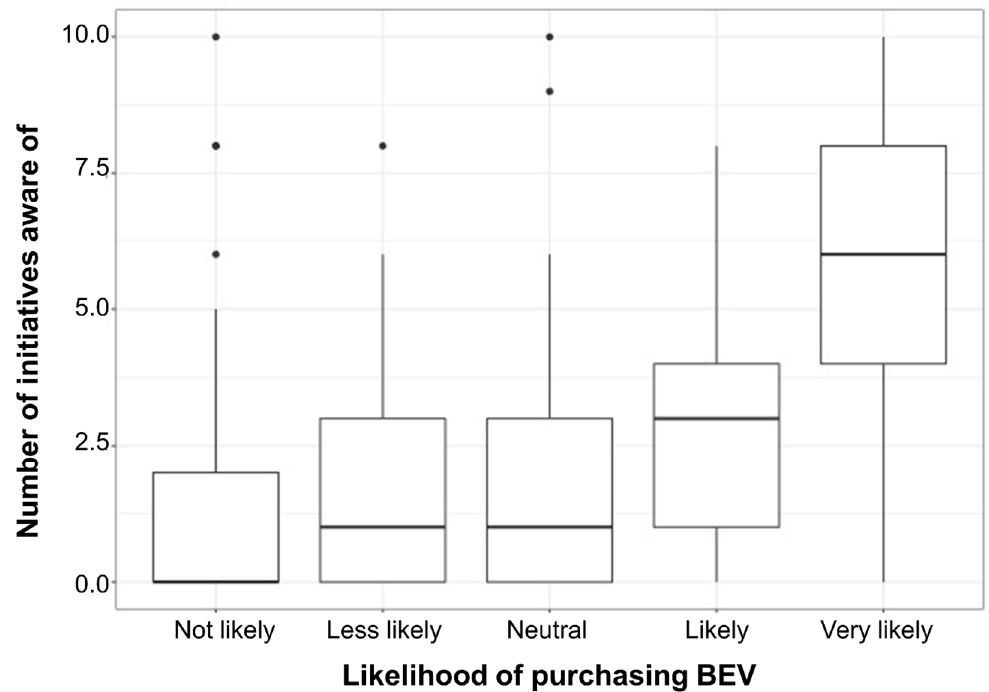
Figure 3. Mosaic plot showing the proportion of primary information sources for each likelihood of buying a BEV score. Written sources, followed by social media, were the most often consulted by those ‘very likely’ to buy a BEV in the future.